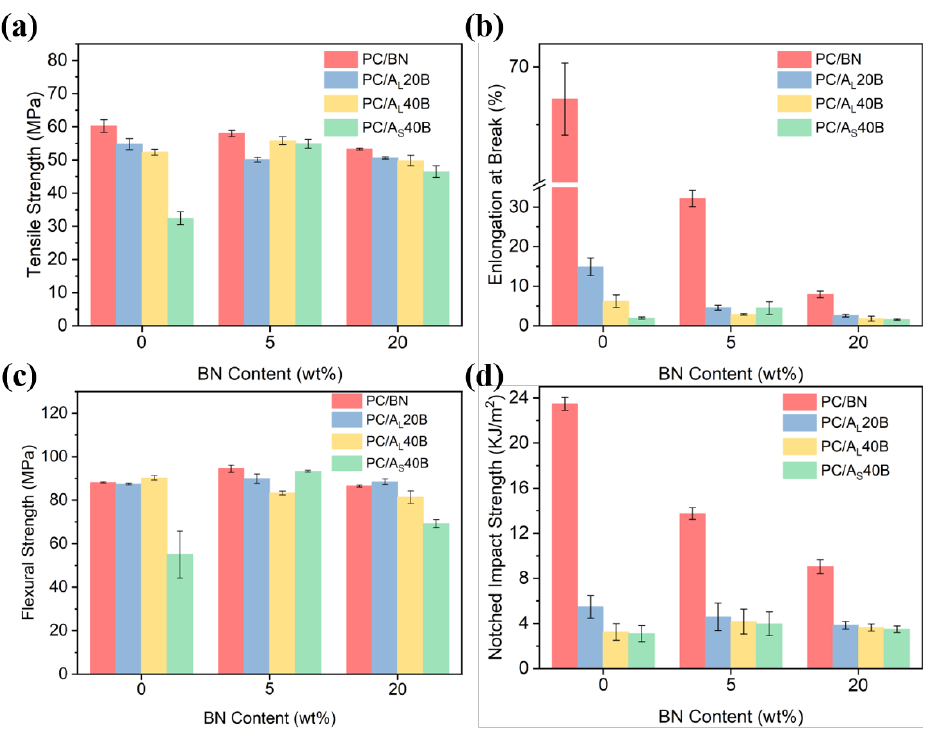
Figure 8. The mechanical properties of PC/BN and PC/Al 2 O 3 /BN composites: ( a ) tensile strength, ( b ) elongation at break, ( c ) flexural strength, and ( d ) notched impact strength.